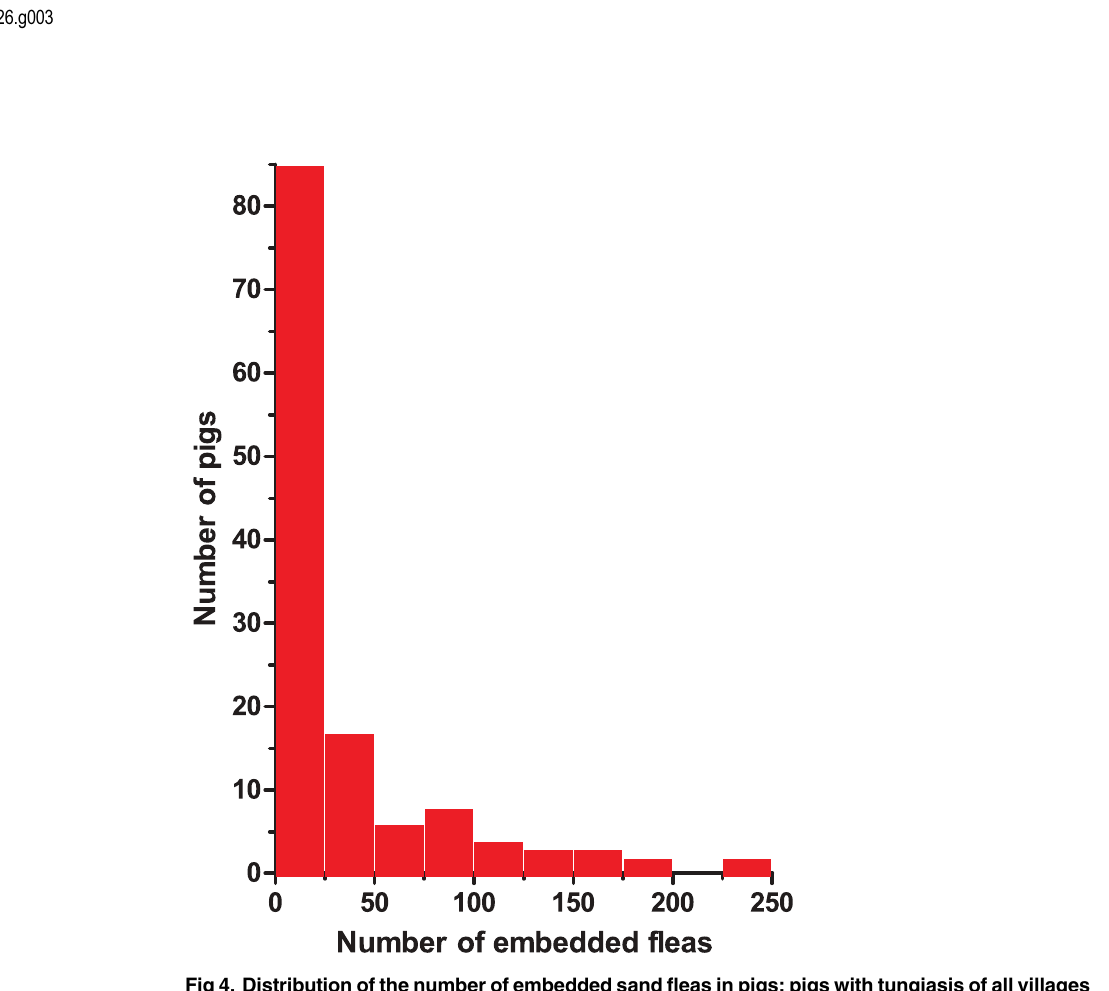
Fig 4. Distribution of the number of embedded sand fleas in pigs; pigs with tungiasis of all villages combined.